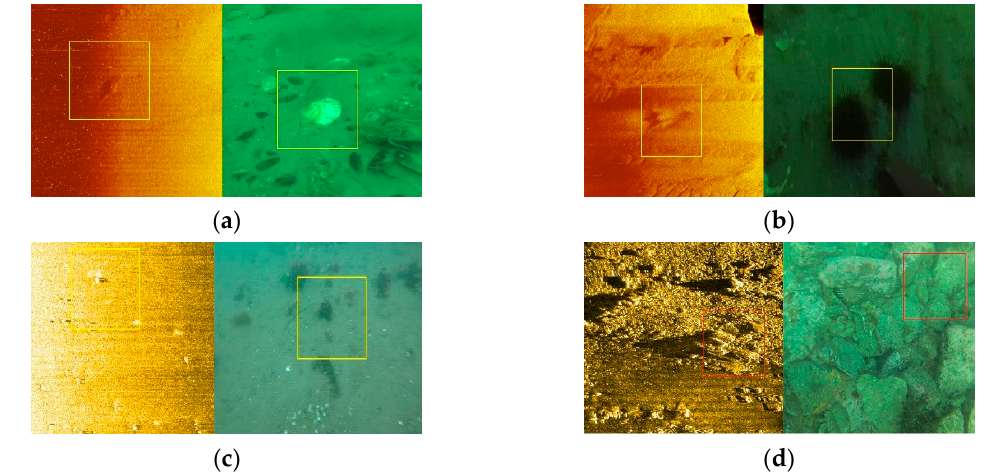
Figure 6. The results of matching. The subfigures ( a ), ( b ), ( c ) and ( d ) in the Figure 6 contains different types of objects, in which( a ), ( b ), ( c ) matcheing successfully and ( d ) failed.